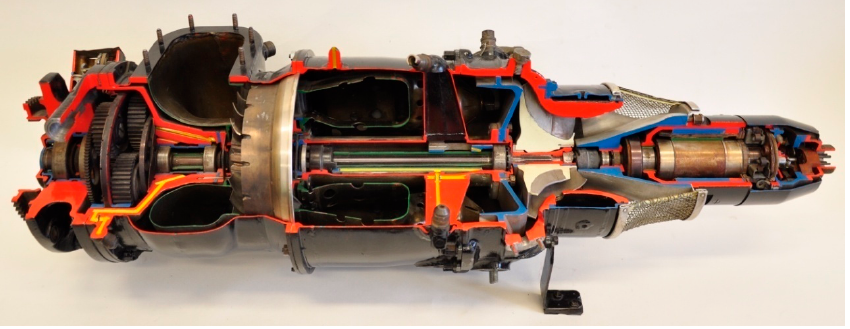
Figure 1. Cut way of TS-20 turbine launcher (Engine AL-7F-1, Technical description, Let-21-33/1, MNO Prague 1968) [30].